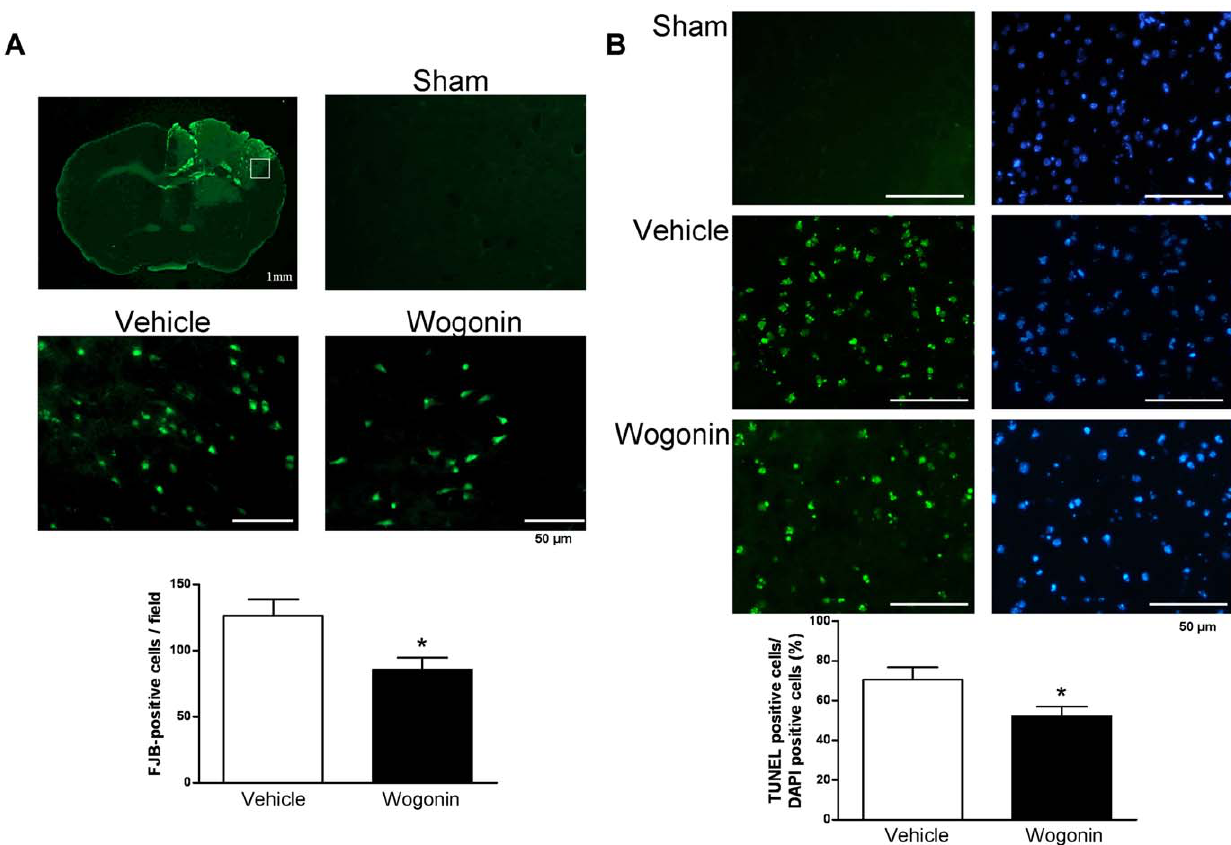
Figure 3. Effects of 40 mg ? kg 2 1 wogonin treatment on neuronal degeneration and apoptotic cell death. ( A ) Brain atlas of coronal sections of a core contusional region at 0.74 mm from the bregma. Quantification analysis indicated that wogonin-treated mice had significantly fewer degenerating neurons than vehicle-treated mice in the cortical contusion margin at day 1 post-TBI. The total number of Fluoro-Jade B (FJB)- positive cells is expressed as the mean number per field of view (1.3 mm 2 ). The scale bar is 50 m m. ( B ) Representative terminal deoxynucleotidyl transferase-mediated dUTP-biotin nick end labeling (TUNEL) staining (green)- and DAPI (blue)-stained brain sections of a sham-injured control, a wogonin-treated mouse, and a vehicle-treated mouse at day 1 post-TBI. Quantification showed that wogonin-treated mice had significantly fewer TUNEL-positive cells than the vehicle-treated mice in the cortical contusion margin at day 1 post-TBI. The percentage of TUNEL-positive cells is expressed as the number of TUNEL-stained nuclei/the total number of DAPI-stained nuclei. Sections were stained with DAPI (blue) to show all nuclei. The scale bar is 50 m m. Values are presented as means 6 SEM; * P , 0.05 versus vehicle-treated injured mice (n=7 mice/group).